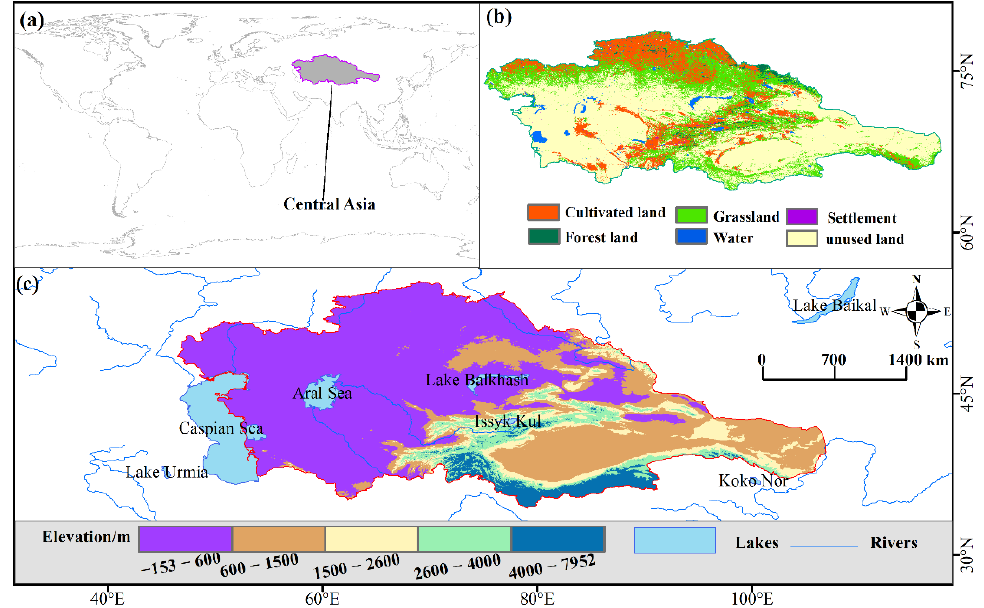
Figure 1. Study area: ( a ) location of Central Asia on the world map; ( b ) distribution of land use conditions in Central Asia; ( c ) elevation changes and distribution of rivers and lakes in Central Asia. The map is based on the standard map number GS (2016) 1666 downloaded from the standard map service website of the National Bureau of Mapping Geographic Information, and the base map is not modified.